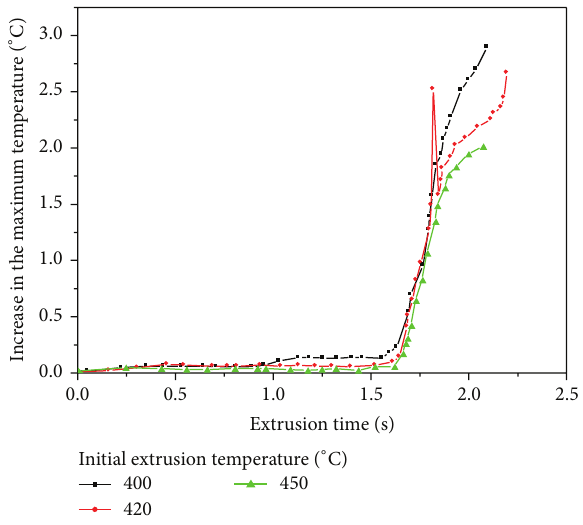
Figure 6: Maximum temperatures for various initial extrusion temperatures during ES extrusion through ES die and at ram speeds of 2 mm/s with preheated temperature 400–420 ∘